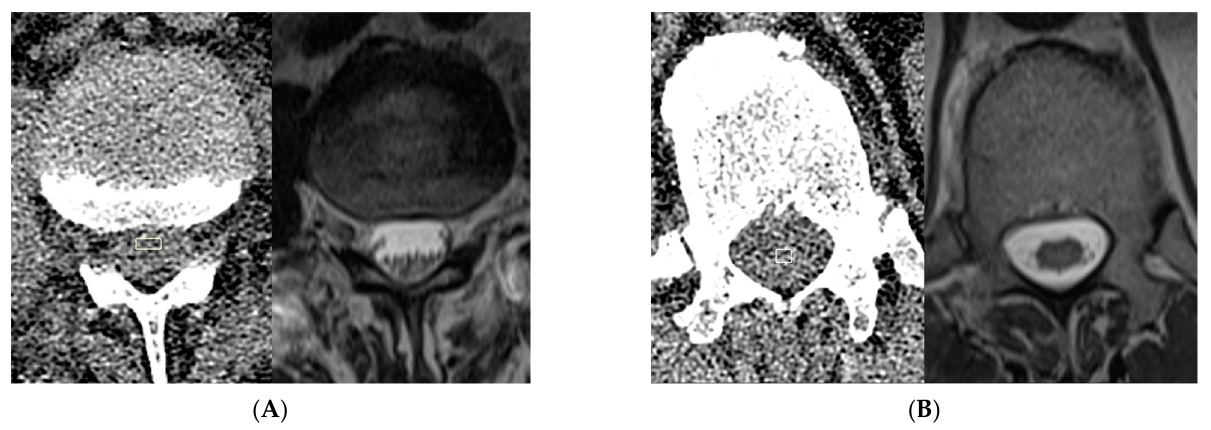
Figure 1. Representative manual ROI selection of ‘water’ and ‘soft tissue’ class voxels. In this example of ‘water’ ROI selection ( A ), the location of a pocket of ventral subarachnoid CSF identified on MRI at the L2 level was selected on CT (rectangle) and applied to multiple consecutive slices to create a 3D ROI in the CT volume for purposes of subsequent subsampling for the ‘water’ class. For this example of intraspinal ‘soft tissue’ ROI selection ( B ), the conus medullaris visualized in the imaged lower thoracic spine on MRI was targeted on CT (rectangle) to similarly create a 3D ROI. Note that there is no readily apparent difference between conus and CSF based on visual inspection of the CT images alone.